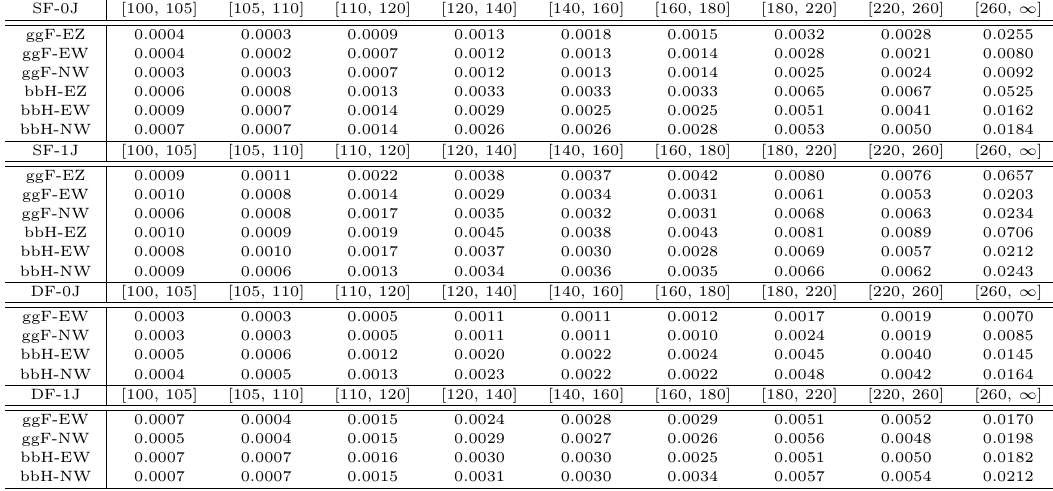
search from each production T